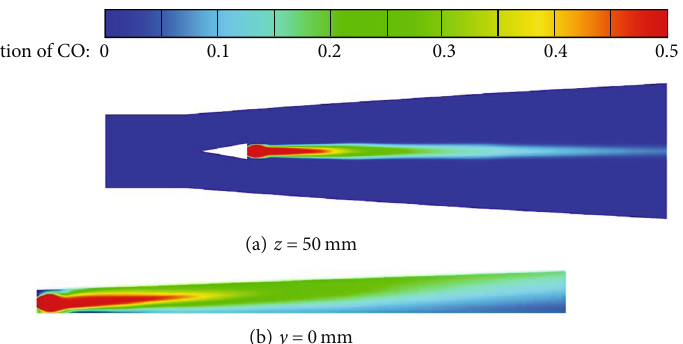
Figure 21: Distribution of mass fraction of